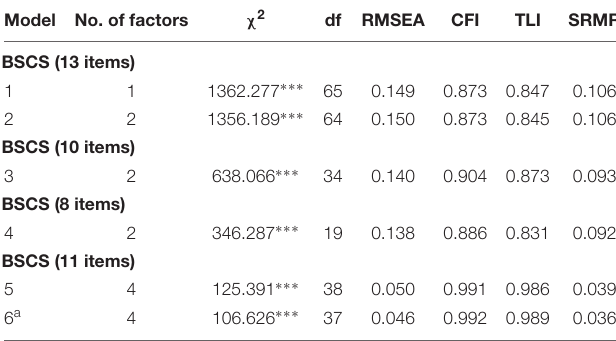
TABLE 5 | Confirmatory factor analysis of the